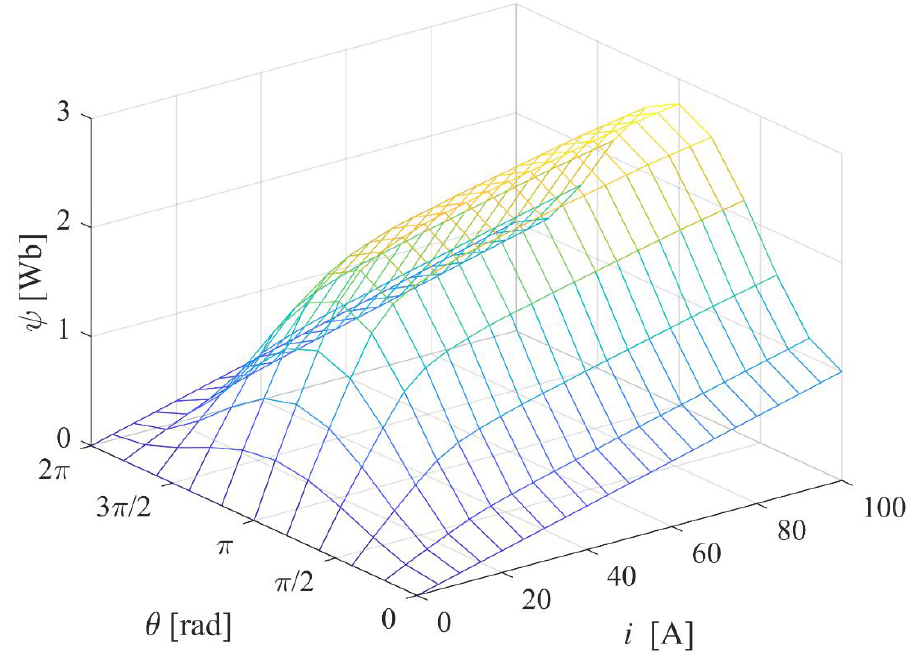
Figure 2. Magnetization surface of the switched reluctance motor (SRM).